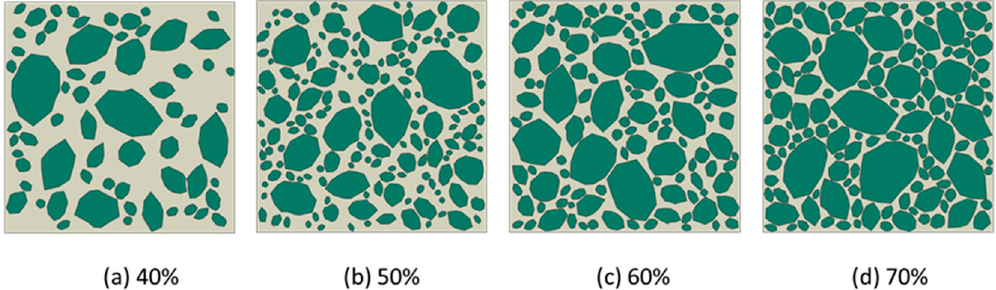
Figure 13. Elongated stone concrete models under different aggregate volume fractions with the scale factor between long and short axes, f ∈ [1,3]. ( a ) 40%; ( b ) 50%;( c ) 60%;( d ) 70%.